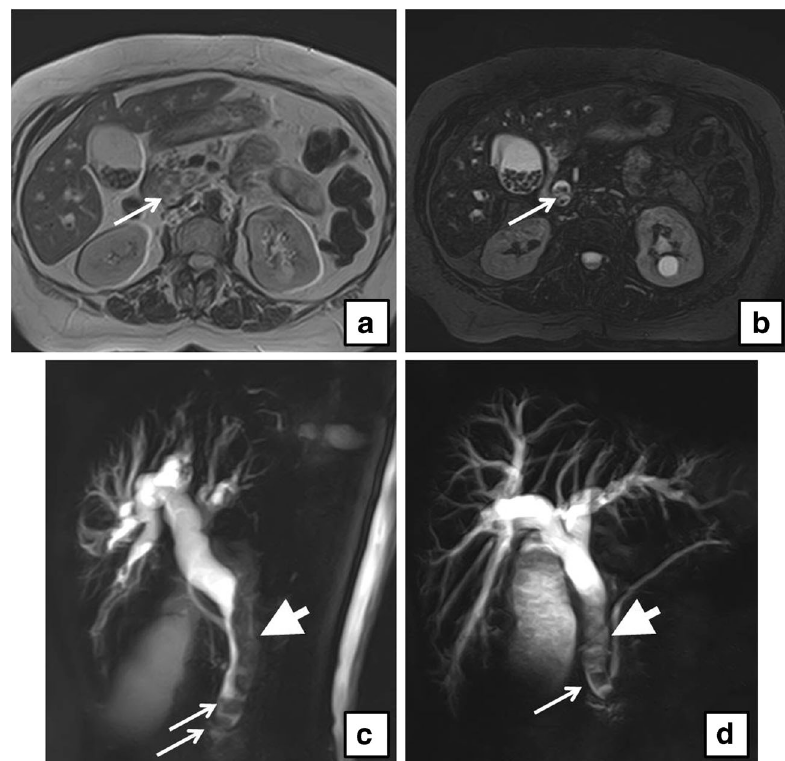
Fig. 4 a Axial T2-weighted MRI shows multiple filling defects in the gallbladder and in the dilated CBD ( arrow ) . b Axial fat- saturated T2-weighted MRI of the same patient at the same level of a . c , d Coronal MIP reformat of the same patient shows multiple filling defects in the gallbladder and in the dilated CBD ( arrowhead ), and two stones are seen in the distal CBD ( arrows )